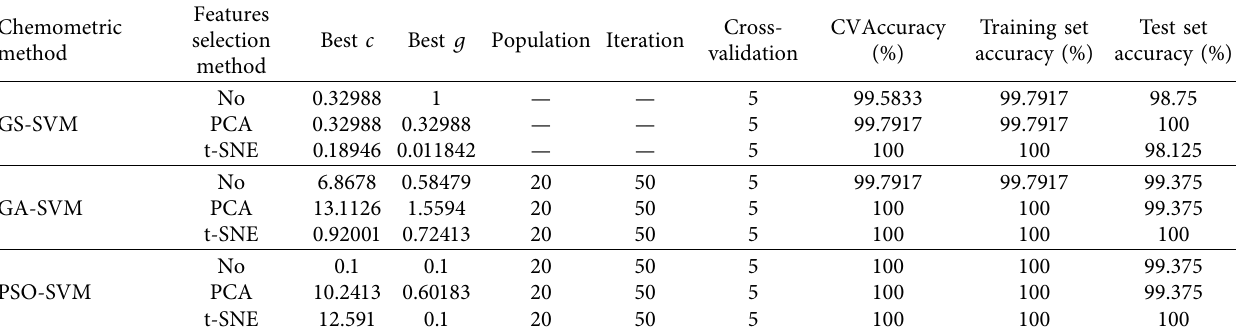
Figure 3: The visualization plots of different types of antibiotics by PCA and t-SNE. (a) Three-dimensional map of the first three PCs. (b) The visualization plots by Table 2: Parameters of grid search, GA and PSO.